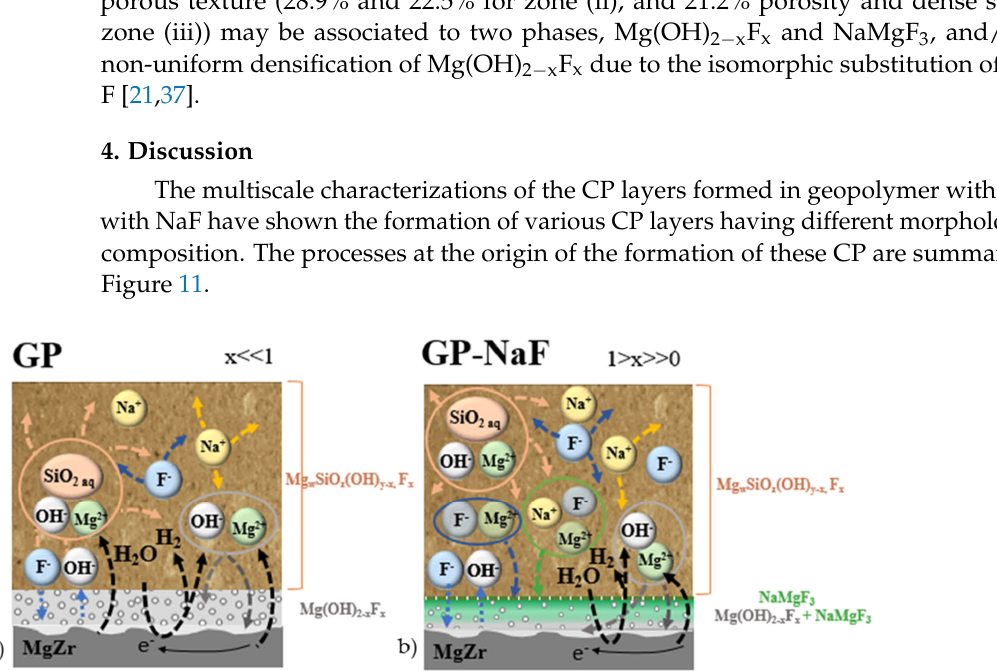
Figure 11. Diagram summarizing the processes which can possibly occur during 3 months of MgZr alloy corrosion in ( a ) GP and ( b ) GP ‐ NaF.